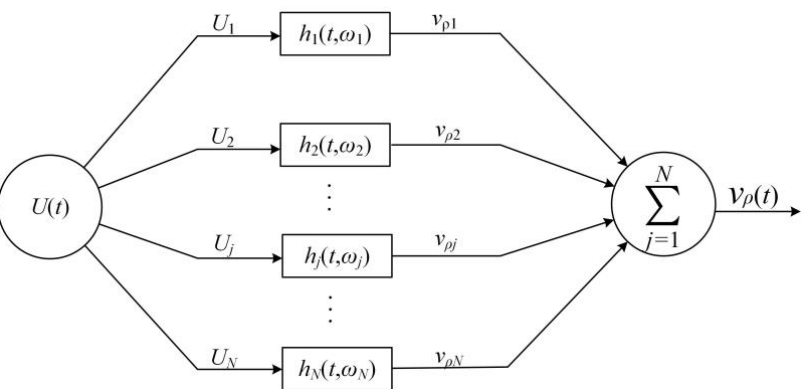
Figure 7. Parallel transmission network model of multifrequency driving-voltage signal U ( t ) exciting transducer: N is the total number of sinusoidal frequency components in the driving-voltage signal; U j is the j th sinusoidal frequency component in the driving-voltage signal; v ρ j is the j th sinusoidal frequency component of the surface vibration velocity of the transducer; h j ( t , ω j ) is the electric–acoustic impulse response of the transducer corresponding to the j th sinusoidal frequency component.